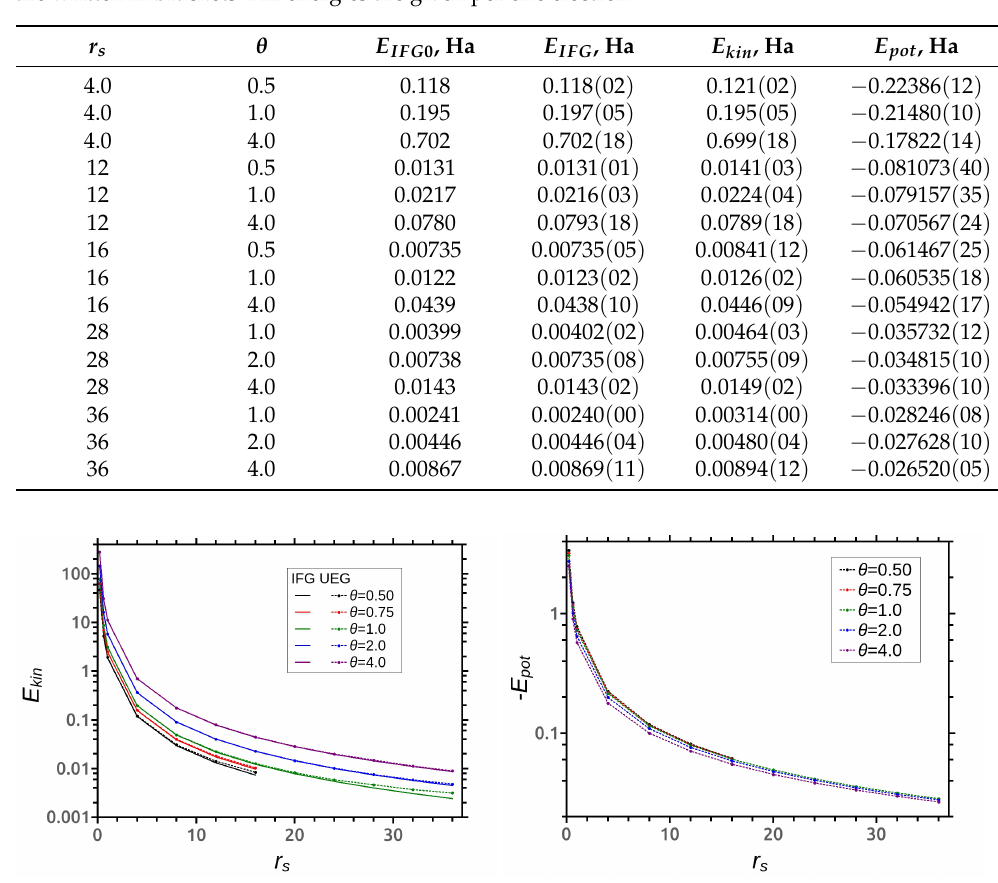
Table 2. E IFG 0 —internal (kinetic) energy of the macroscopic IFG obtained from the analytical Fermi distribution; E IFG —internal (kinetic) energy of the finite-size IFG obtained from the SMPIMC; E kin and E pot —kinetic and potential energy of the UEG. Two significant digits of the statistical error 3 σ are written in brackets. All energies are given per one electron.